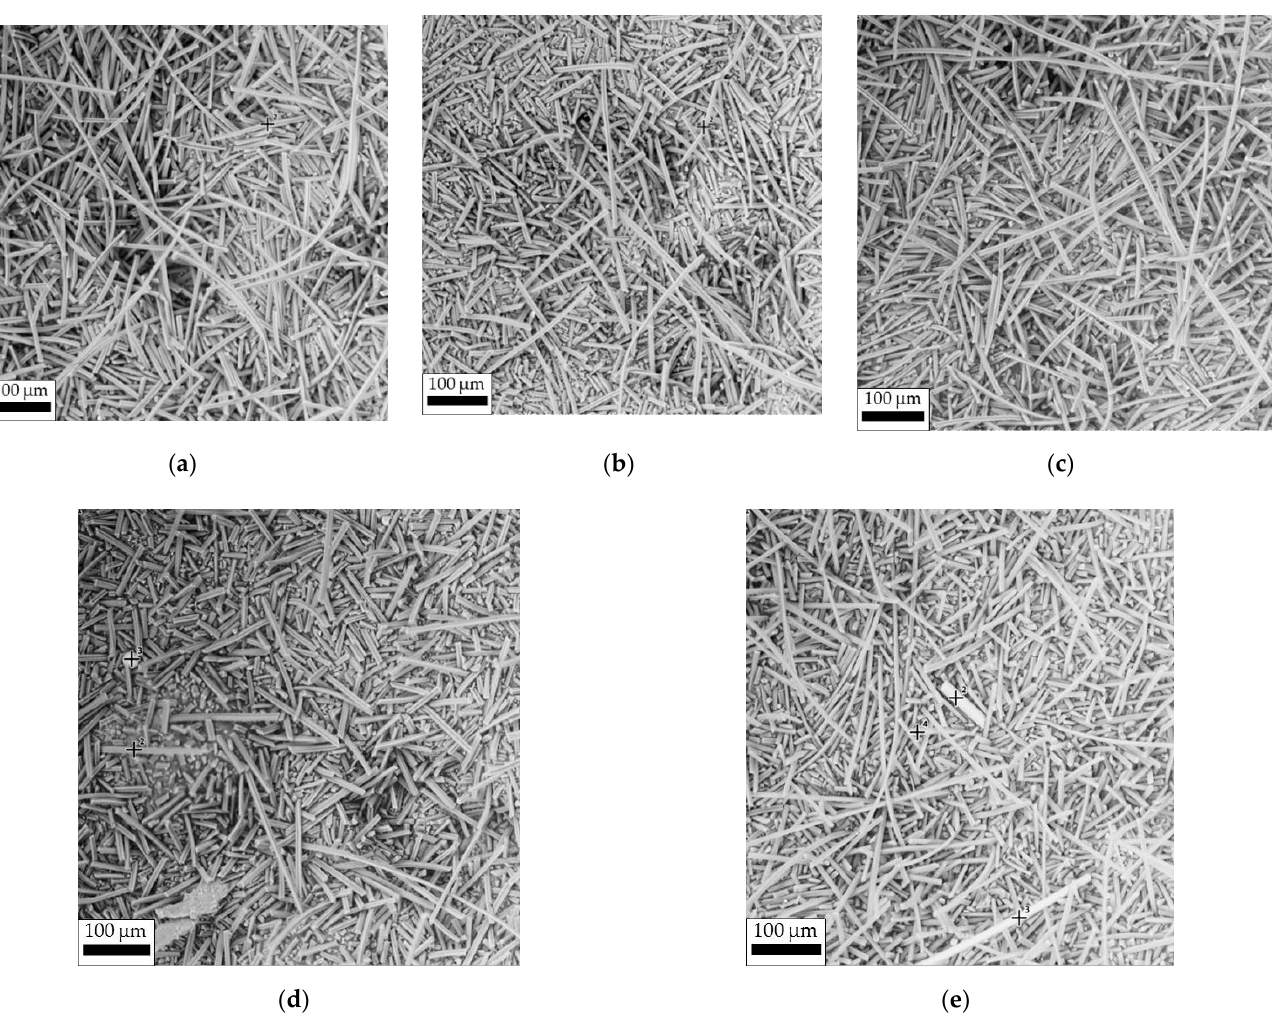
Figure 1. SEM images of the prepared CFs: ( a ) sample S12; ( b ) sample S22; ( c ) sample S23; ( d ) sample P11; ( e ) sample P21.